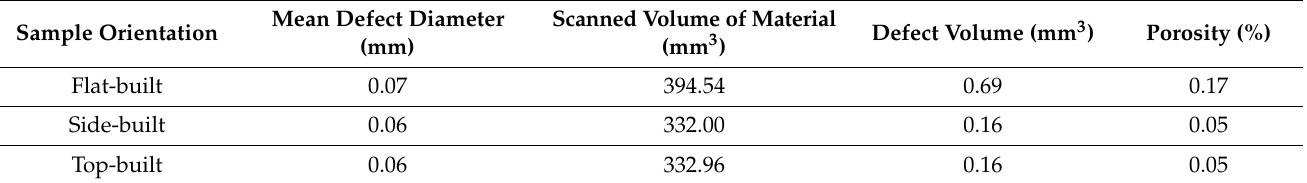
Table 2. 3D X-ray computed tomography (CT) analysis data of the three as-built EBM Ti6Al4V samples built in different